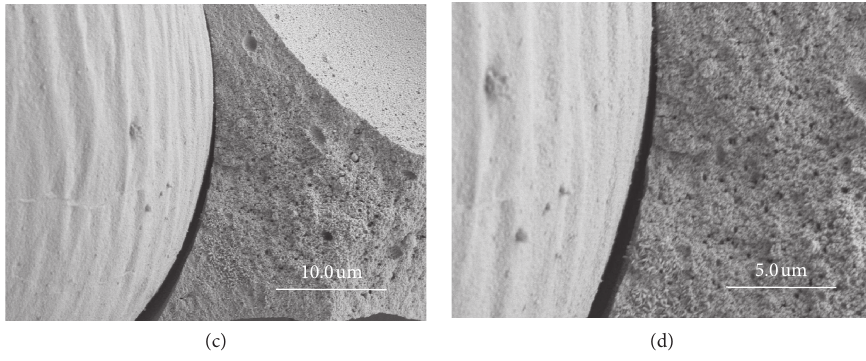
Figure 11: SEM images of the C17-1%